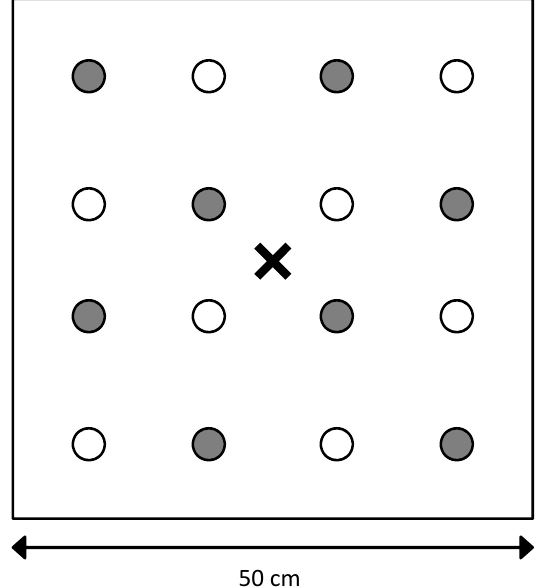
Fig. 1. Positioning of P-fertilized (grey circles) and unfertilized soil cores (unfilled circles) around single L. corniculatus plants (cross) on plots (50 × 50cm) with heterogeneous P supply of the ingrowth core experiment. Soil cores were arranged on a 14 × 14cm grid re- sulting in 4, 8 and 4 soil cores at 10, 22 and 30cm distance from the plant, respectively.